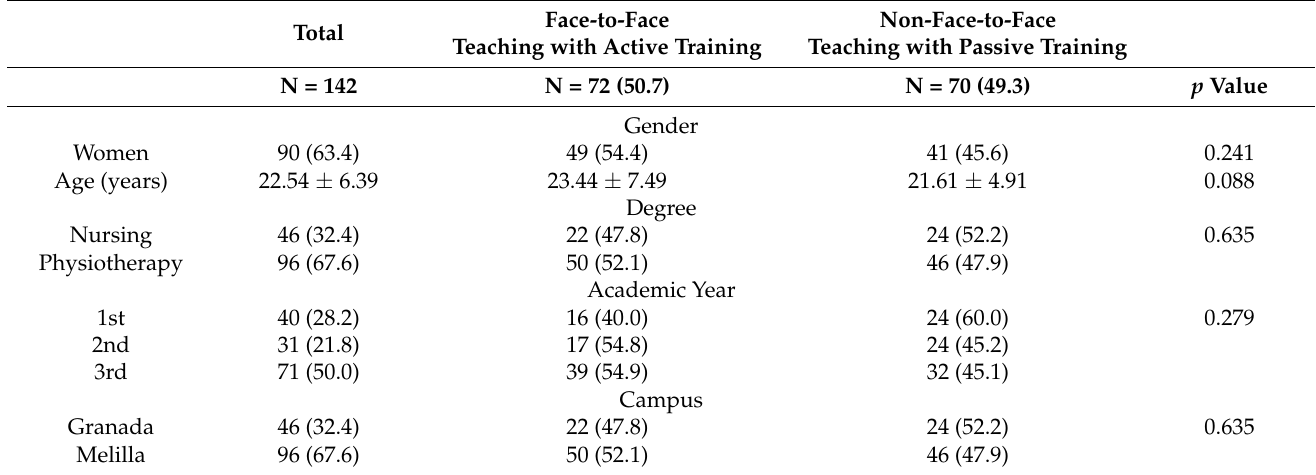
Table 1. General characteristics of the participants according to the training